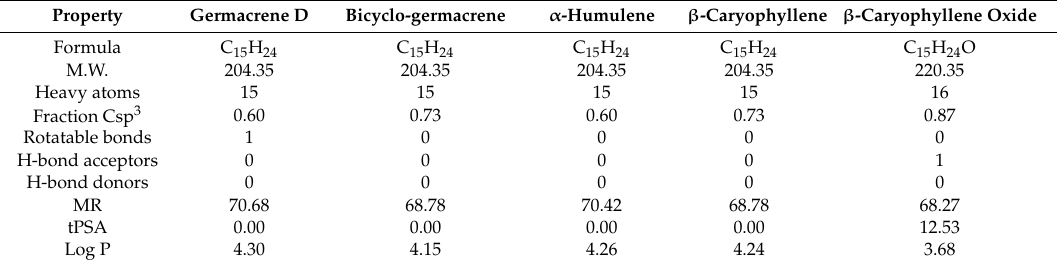
Physicochemical properties of ( − )-germacrene D, bicyclogermacrene, α -humulene, ( − )- β -caryophyllene, and β -caryophyllene